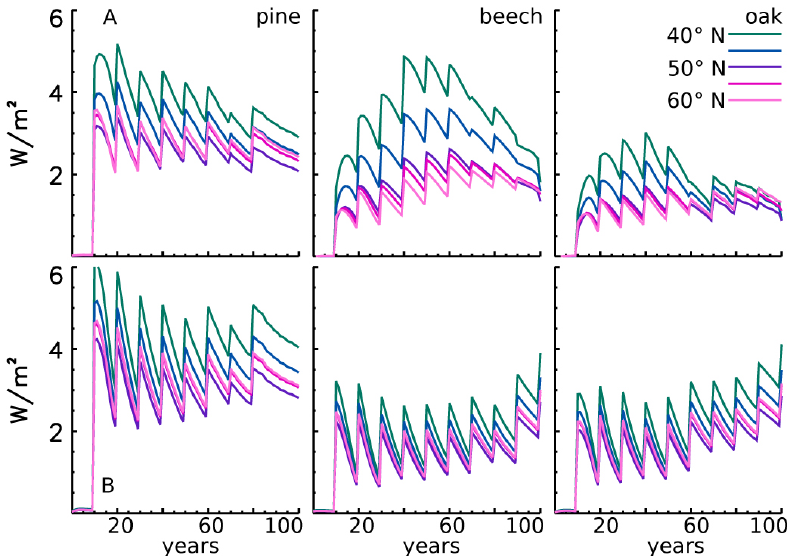
Fig. 9. Local radiative forcing for June calculated over a rotation for all three species and resulting from the difference between unmanaged and intensely thinned forest for the transect along the line of longitude at 9 ◦ E stretching from 40 ◦ to 60 ◦ N in discrete 5 ◦ steps. The upper row (A) shows the radiative forcing for the black-sky albedo; the lower row (B) shows the radiative forcing for the case of white-sky albedo.